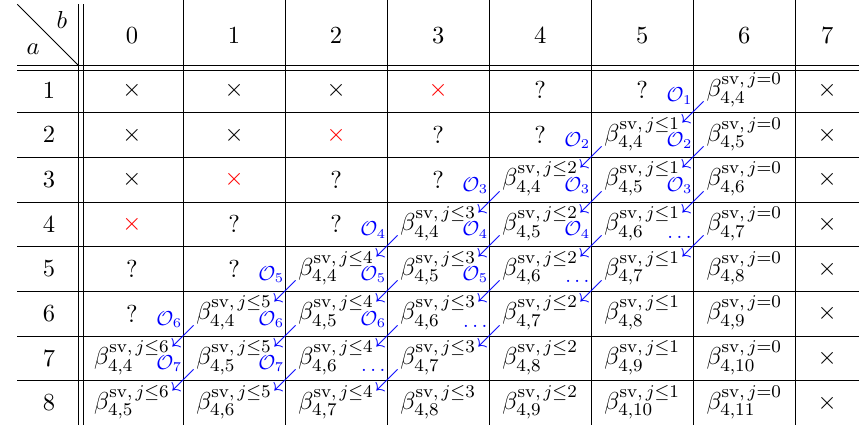
obtained from Poincaré sums over y a E 4 ,k defined in ‘